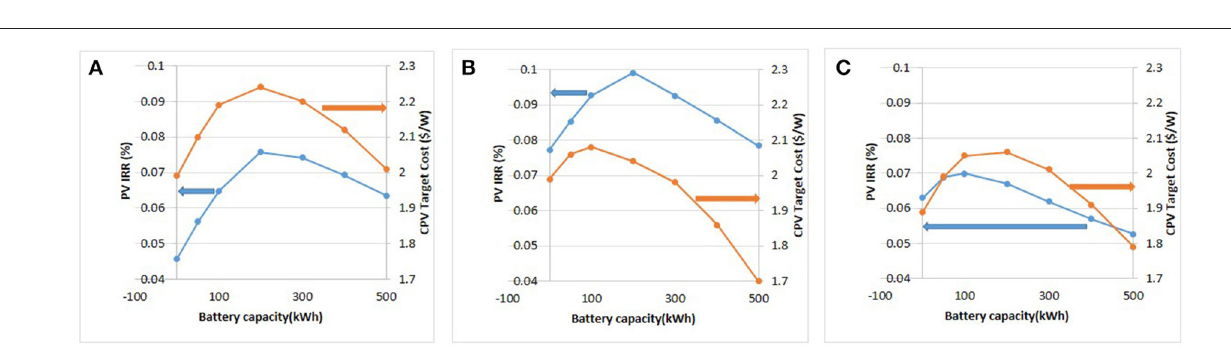
5 p.m. load profile, 200 kWh battery. −